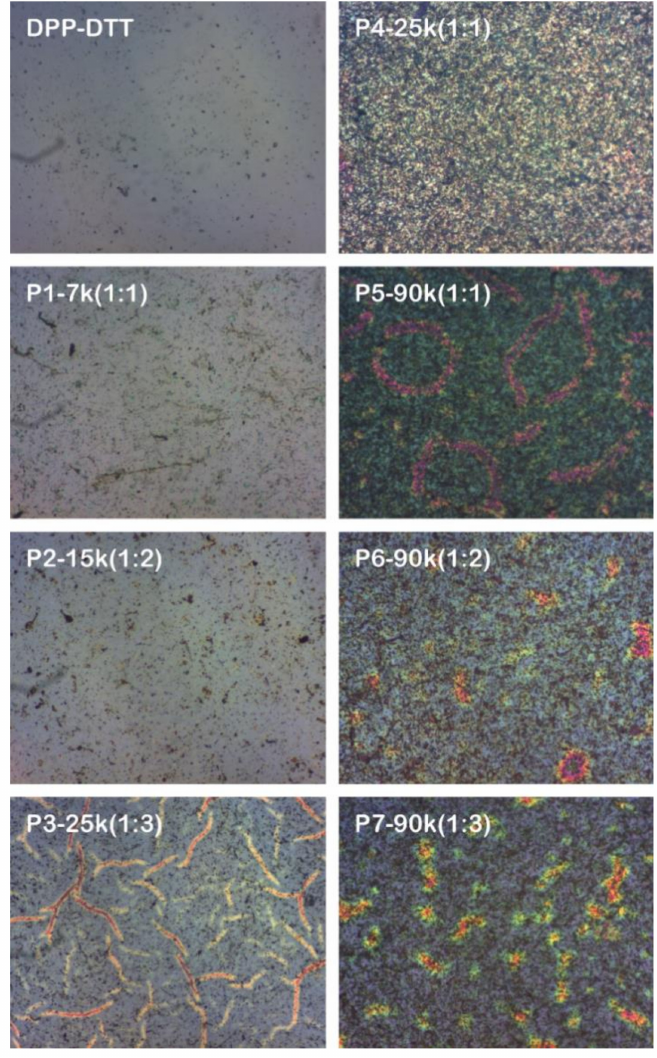
Figure 4. Opticalimagesofthelayersdeposited byMAPLEonITO / PEDOT:PSS(500 × , 150 µ m × 120 µ